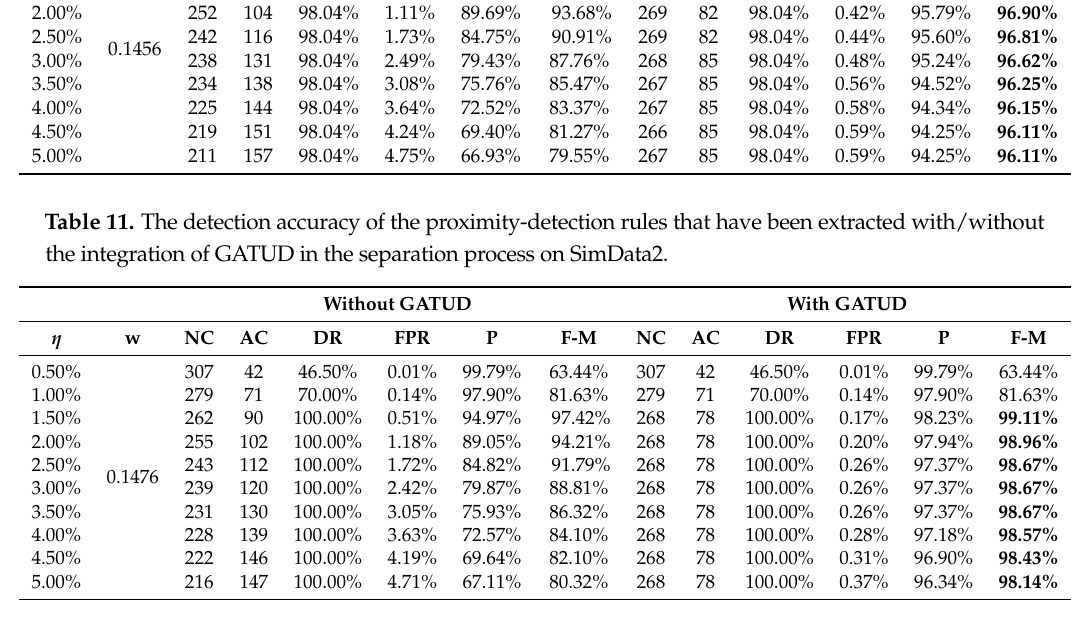
Table 12. The detection accuracy of the proximity-detection rules that have been extracted with/without the integration of GATUD in the separation process on SIRD. Without GATUD With GATUD 0.50%